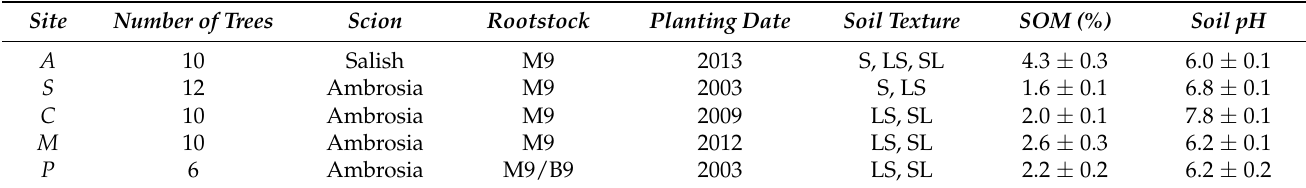
Table 1. Tree and soil descriptions of five sampling